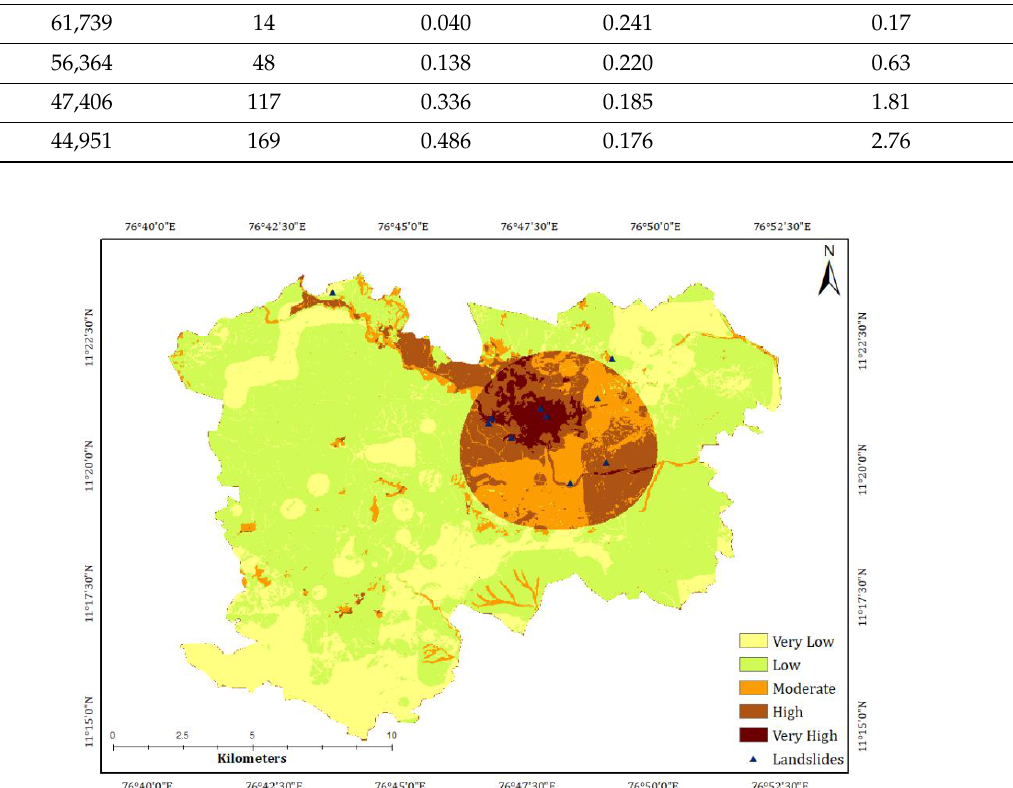
Figure 3. Landslide Susceptibility Map of Coonoor Taluk of Nilgiris District, India using Logistic Regression Model.